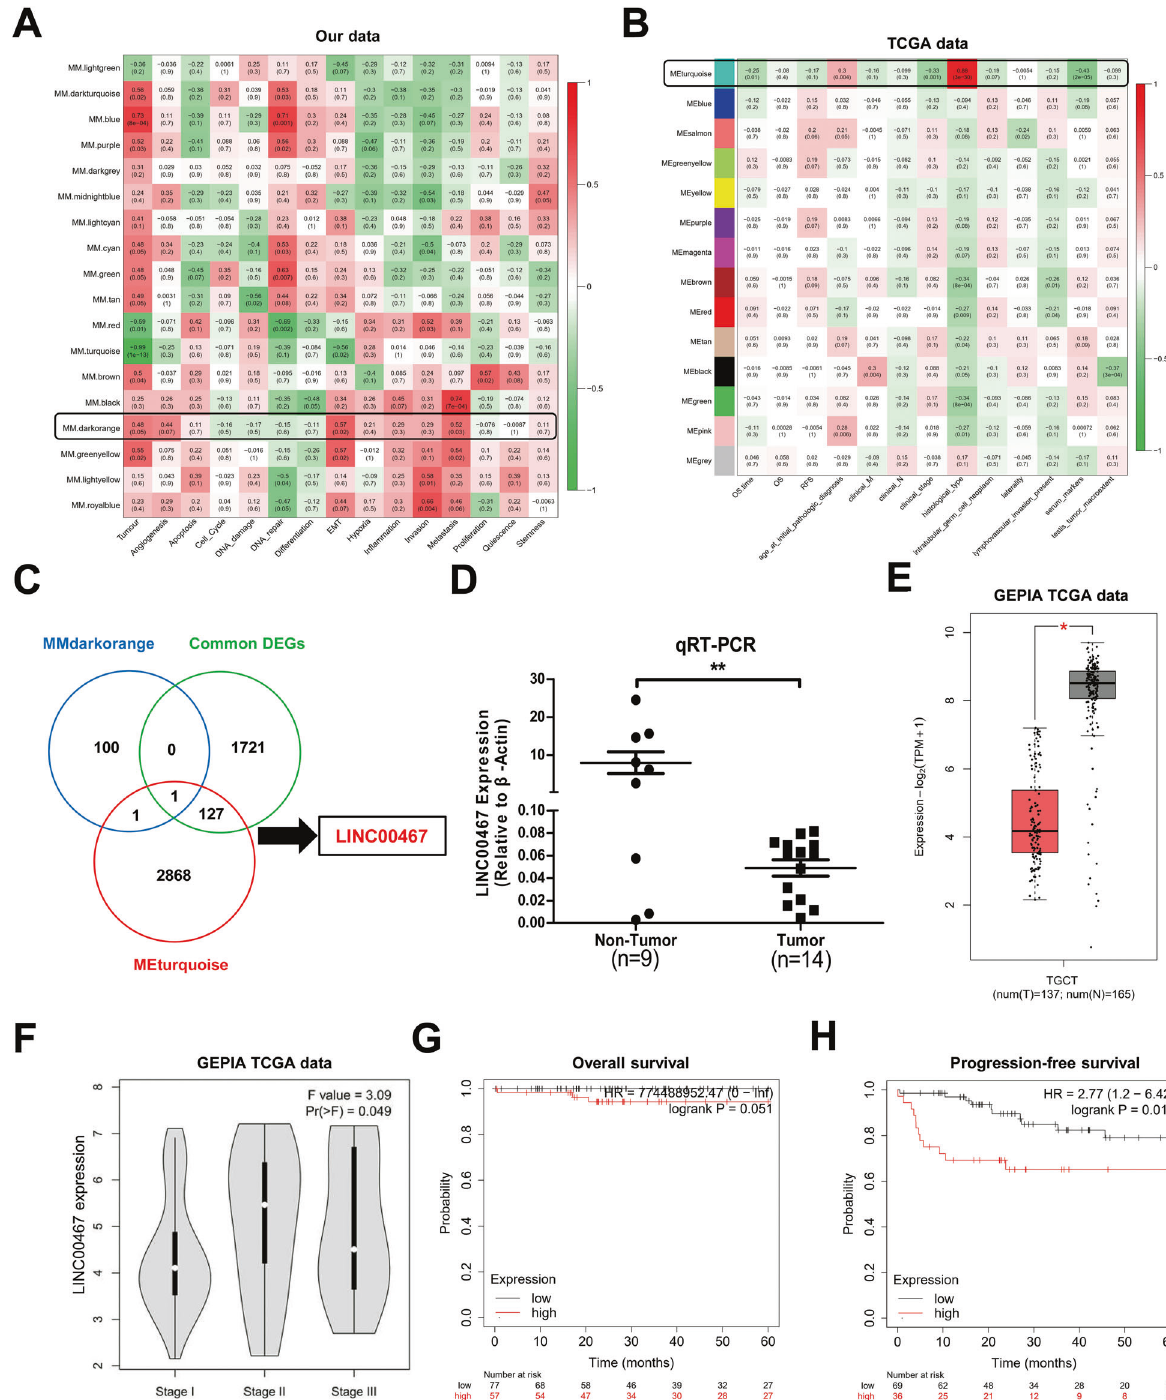
Fig. 4 LINC00467 expression is signi fi cantly correlated with clinicopathological features, metastasis, and the prognosis of TGCT. A , B WGCNA analysis of the clinical phenotype module correlation using self-tested RNA sequencing data ( A ) and TGCT data from TCGA database ( B ). C MMdarkGreen module, Meturquoise module, and Wayne diagram of the differential lncRNAs. D , E Quantitative real-time PCR ( D ) and GEPIA database TCGA data ( E ) were used to verify the differential expression of LNC00467 in TGCT. F Expression level of LINC00467 in the TGCT dataset of the GEPIA database was associated with the pathological grade of TGCT. G , H , TGCT data from the Kaplan-Meier Plotter database were used to analyze the correlation between LINC00467 and the prognosis of TGCT patients. [10] and NCCIT (non-seminoma cell line) [11] for further in vitro Effects of LINC00467 on the migration, invasion, and clone experiments. The expression levels of LINC00467 in NCCIT and formation of TGCT cells Tcam-2 were determined using qRT-PCR to verify the effects of the Since TGCT can be divided into two types: seminoma and non- overexpression and silencing of LINC00467 (Fig. 5A, B), followed seminoma, we selected two cell lines Tcam-2 (seminoma cell line)